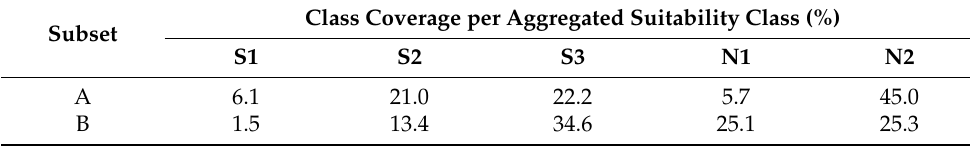
Table 6. Class coverage area per aggregated soybean suitability class.